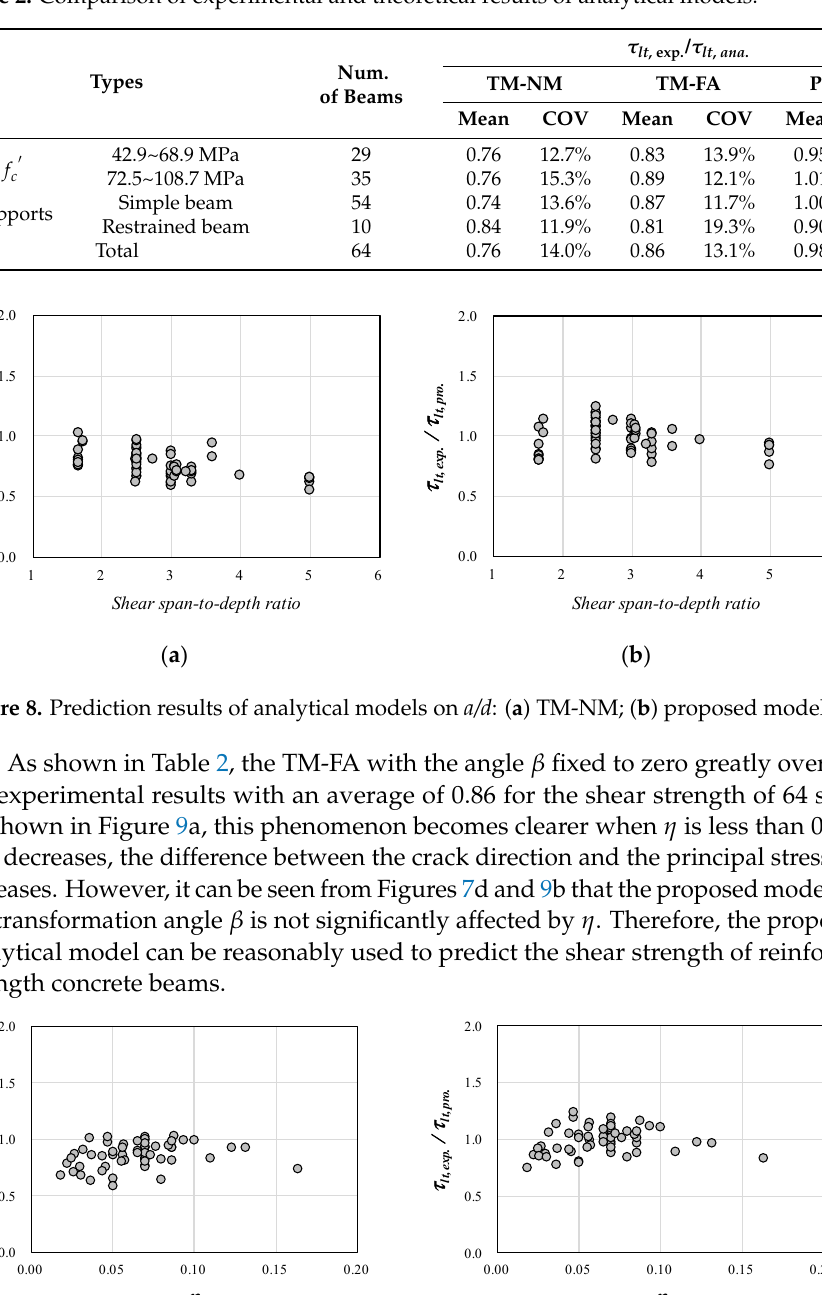
Table 2. Comparison of experimental and theoretical results of analytical models.